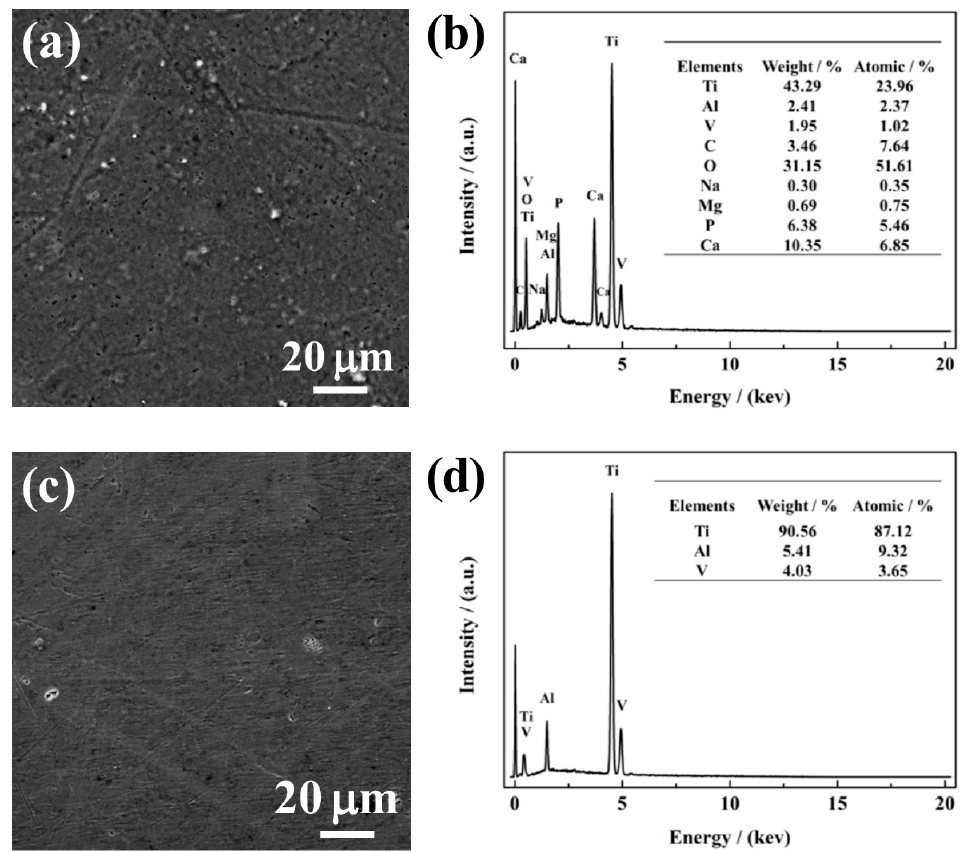
Figure 6. SEM micrographs with the corresponding EDS analysis of NG ( a and b ) and CG ( c and d ) Ti–6Al–4V alloys immersed in SBF solution for 720 h.